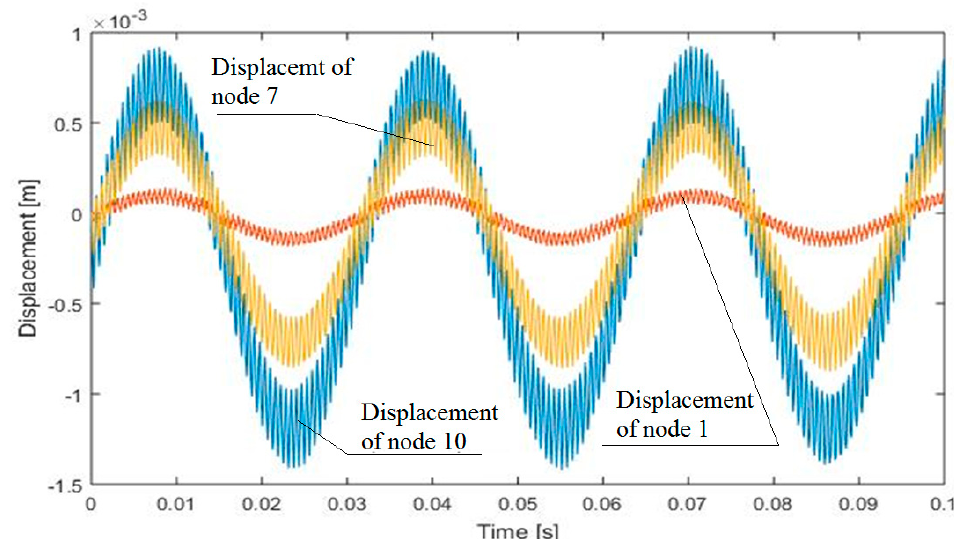
Figure 2. Axial displacement of the node 3, 7, 10 (10 finite elements, 11 nodes), without damping.